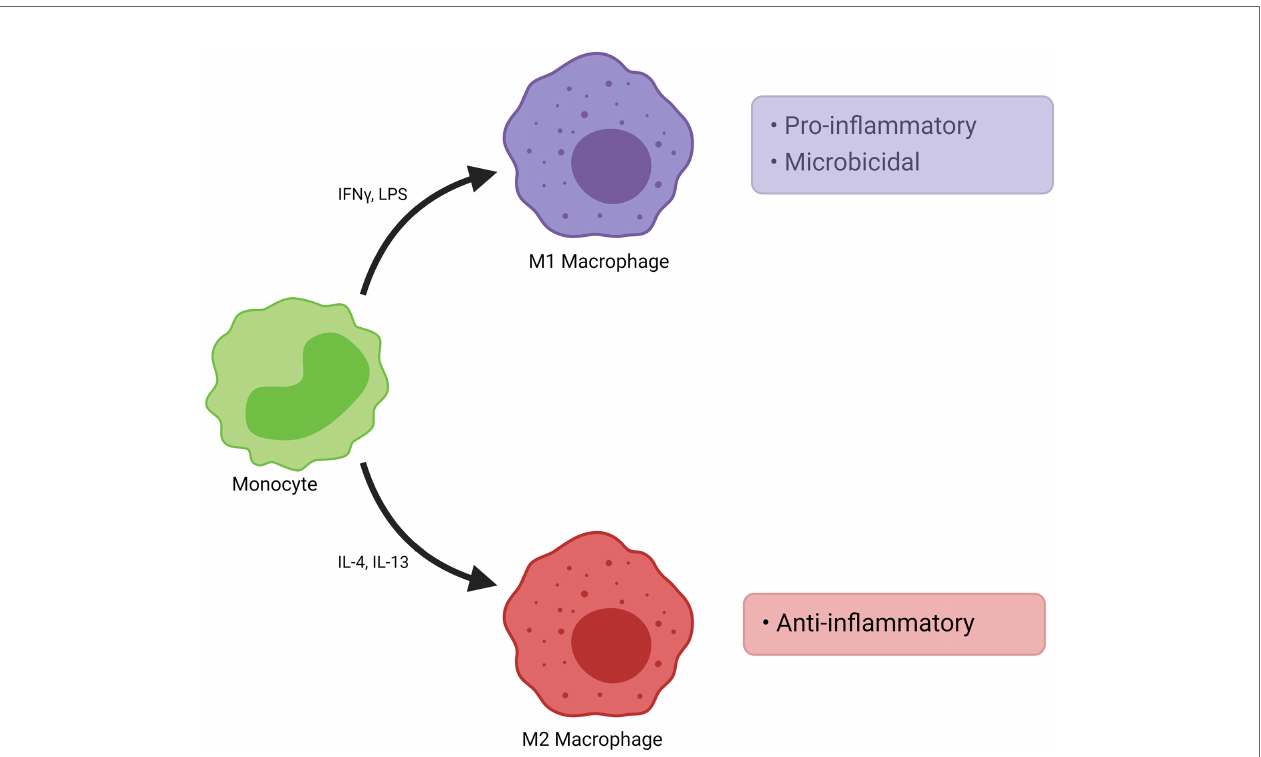
FIGURE 6 | Polarization of Macrophages. Monocytes from blood differentiate into functionally distinct populations. M1 macrophages are induced by various stimuli such as IFN g . They demonstrate pro-in fl ammatory and microbicidal effects. M2 macrophages are induced by stimuli such as IL-4, IL-13 and they show anti- in fl ammatory effects. M2 macrophages may be further divided into subpopulations such as M2a, M2b and M2c. IFN g , interferon gamma; IL, interleukin; LPS,